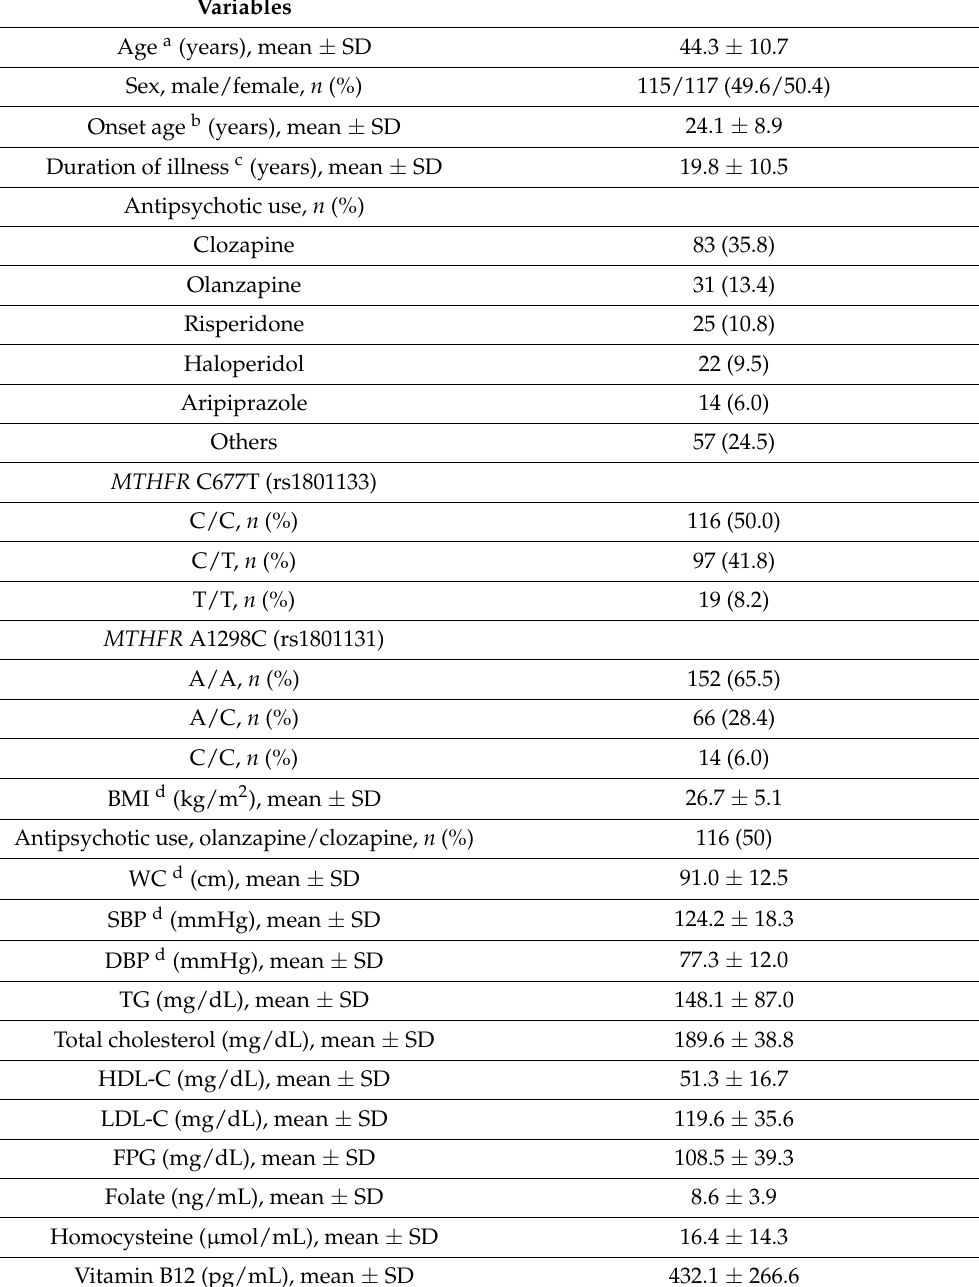
Table 1. Demographic characteristics, MTHFR genotypes, and metabolic parameters of patients with schizophrenia ( n =